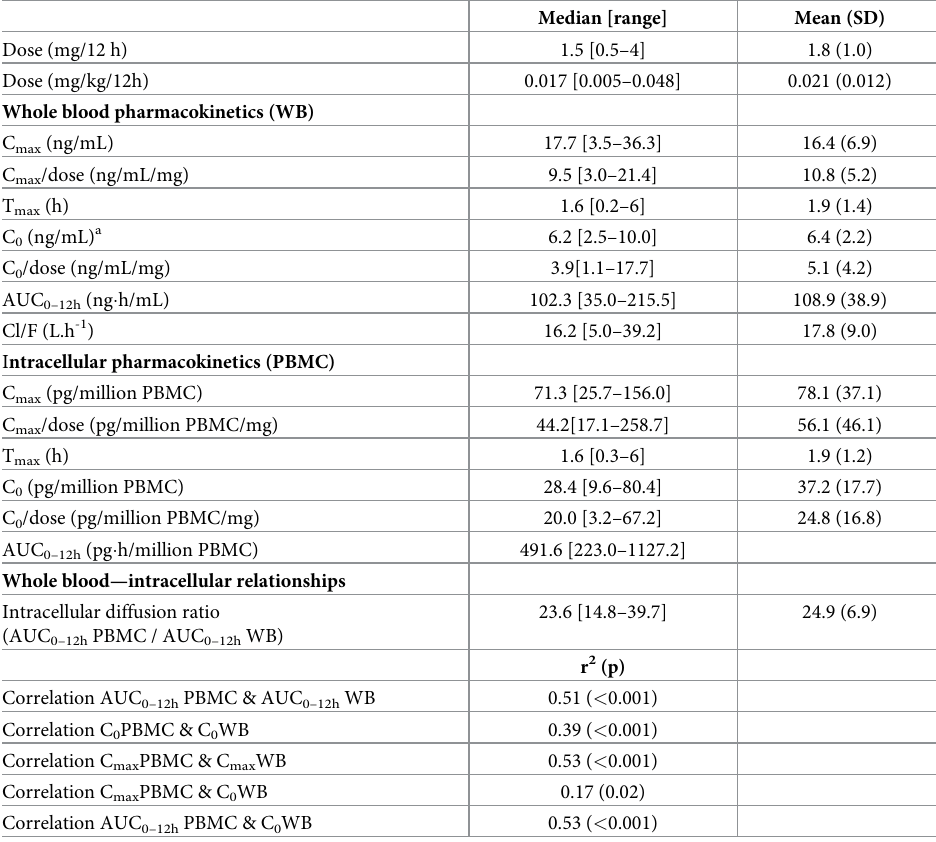
Table 2. Tacrolimus pharmacokinetics parameters in whole blood and PBMC (n =